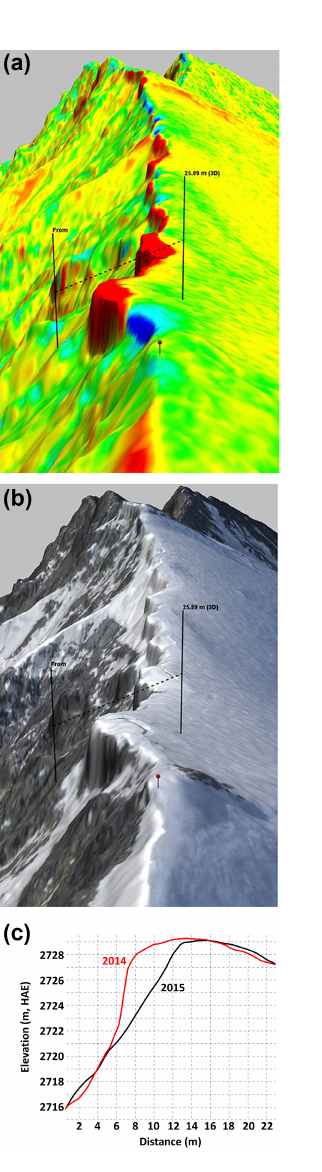
Figure 5. Temporal dynamics of cornices near the peak of Mt. Isto (red push pin). Shown here are 3-D oblique visualizations of fodar from (a) 6 July 2015 and (b) a difference image between 6 July 2015 and 22 April 2014. The consistency of the greens and yellows on either side of the ridge in (b) indicates that there are no spatial mis- alignments of the two data sets and clearly reveals the differences in cornice size between acquisition dates. The profile comparison (c) confirms visual inspection of the ridge line – a cornice about 5m wide and 10m high formed, perhaps during a single storm. With these tools we can clearly measure subtle topographic changes in steep mountain environments that would otherwise be impossible to detect or measure, and comparisons like these show change down to the centimeter scale. Dynamics can also be addressed, as the crevassing behind these new cornices (a) indicates the existing ones are ready to spall and the blue colors (b) indicate that many already have.